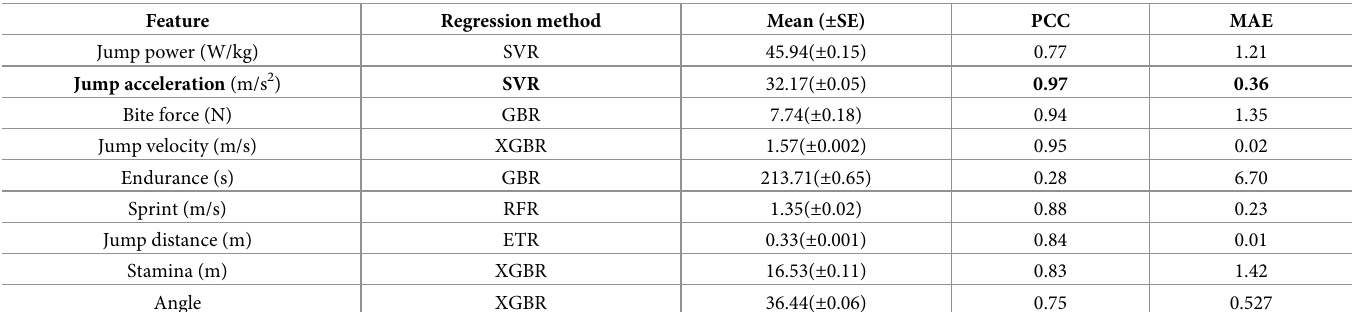
Table 4. Pearson correlation coefficient (PCC) and mean absolute error (MAE) of features. Jump acceleration exhibited the highest prediction accuracy (bolded). To aid in the interpretation of MAE, we have also provided the mean value for each performance feature from the overall training dataset, as well as the associated standard errors. Note that MAE has the same units as the associated performance trait.